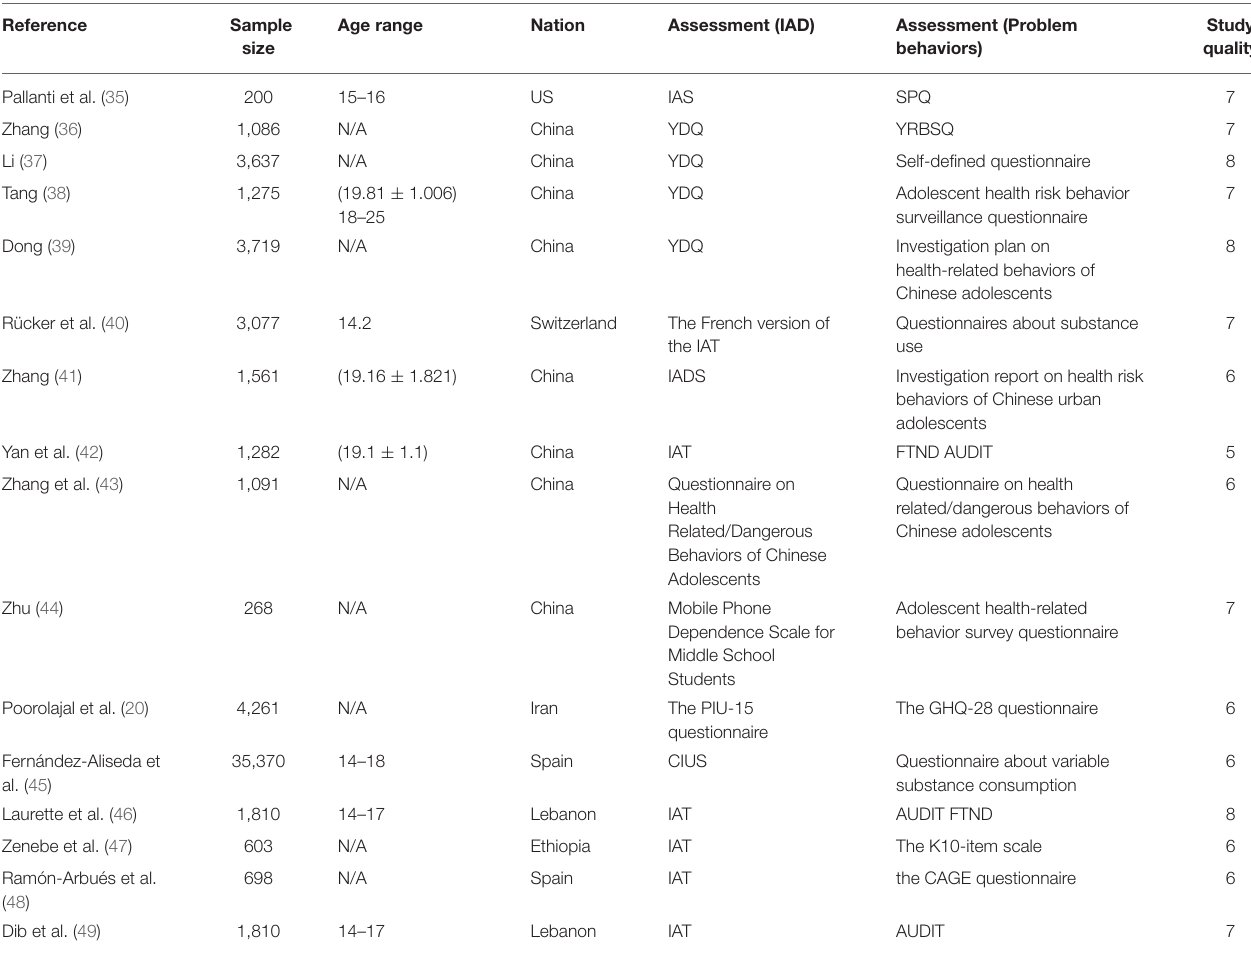
TABLE 1 | Characteristics of the included